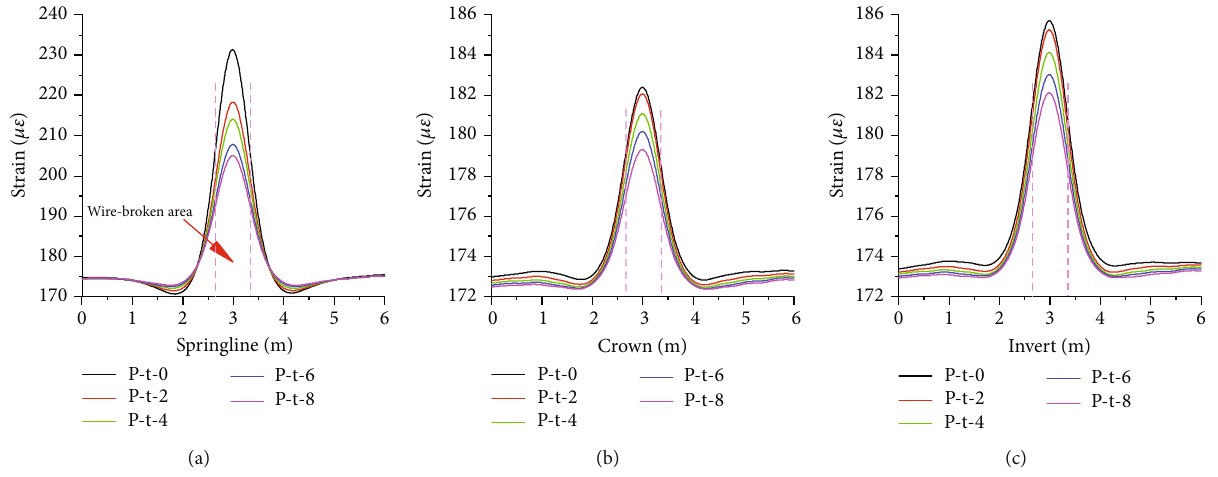
Figure 8: Circumferential strain of the steel cylinder under combined loads: (a) springline; (b) crown; (c)